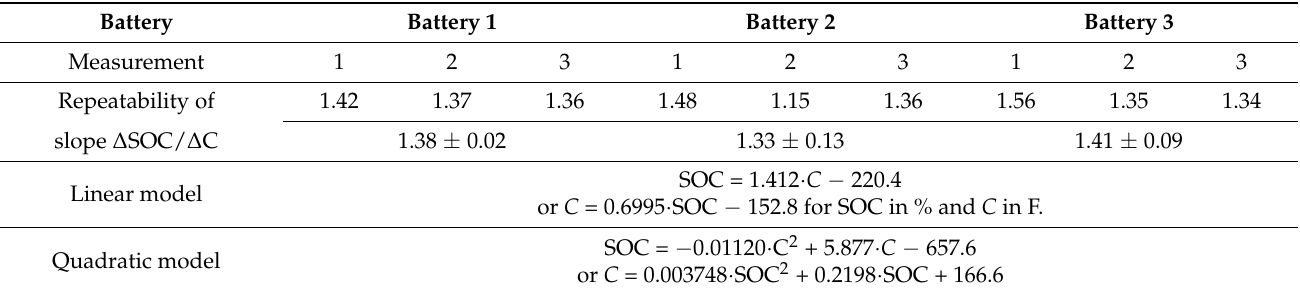
Table 2. Validation of the linear correlation between state-of-charge and pseudocapacitance for three lithium-iron phosphate batteries of the same manufacturer.